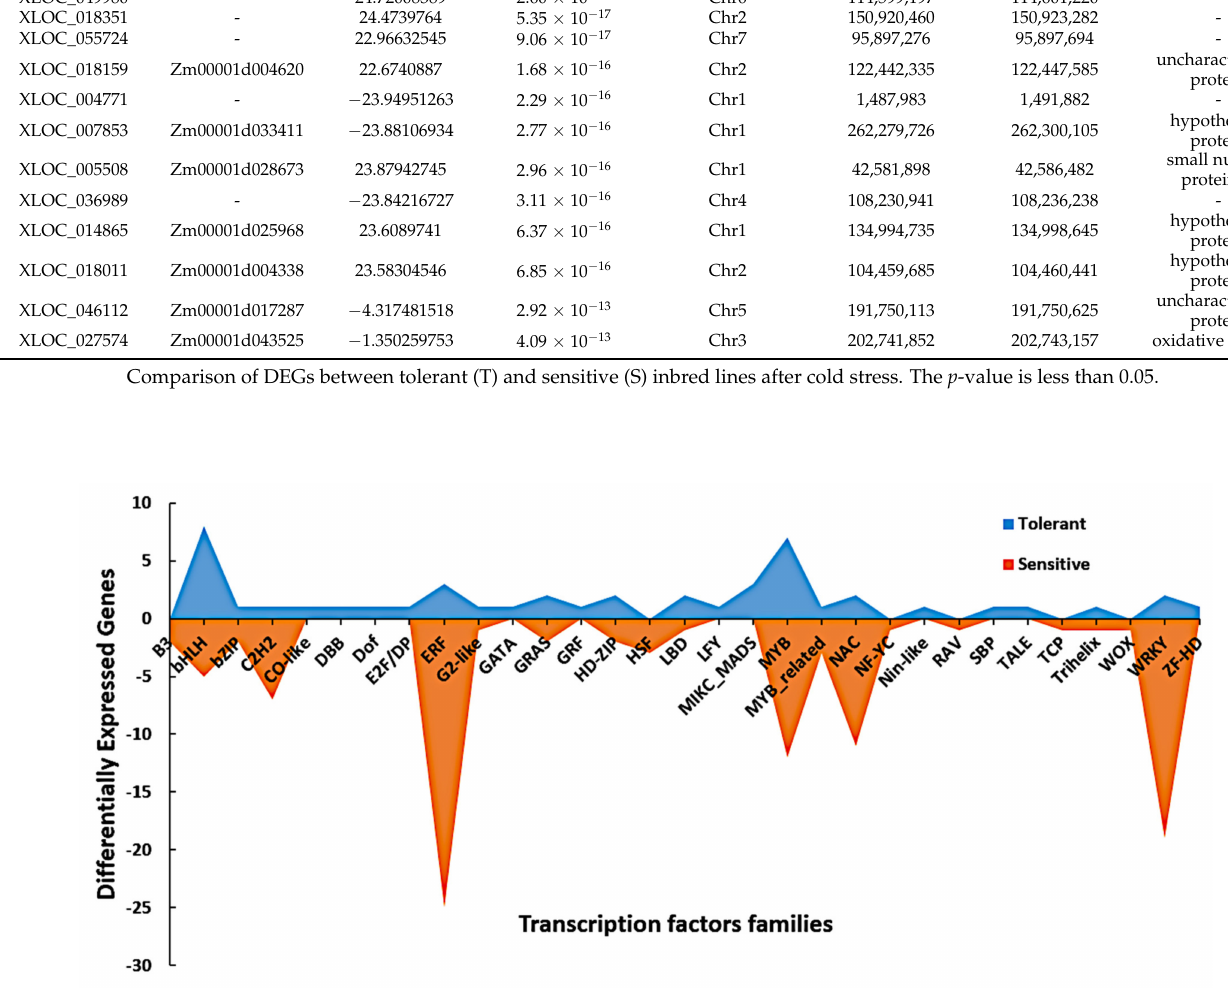
Figure 9. Area map of the various transcription factor families regulated by cold stress. The x -axis represents the TF families, while the number of genes per family is represented by the y -axis. The blue and orange colors indicate the TFs regulated in the tolerant and sensitive lines,